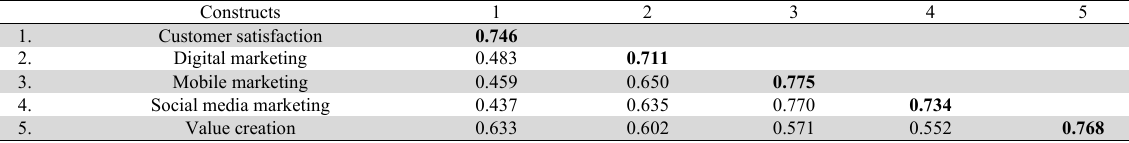
Fornell-Larcker Criterion